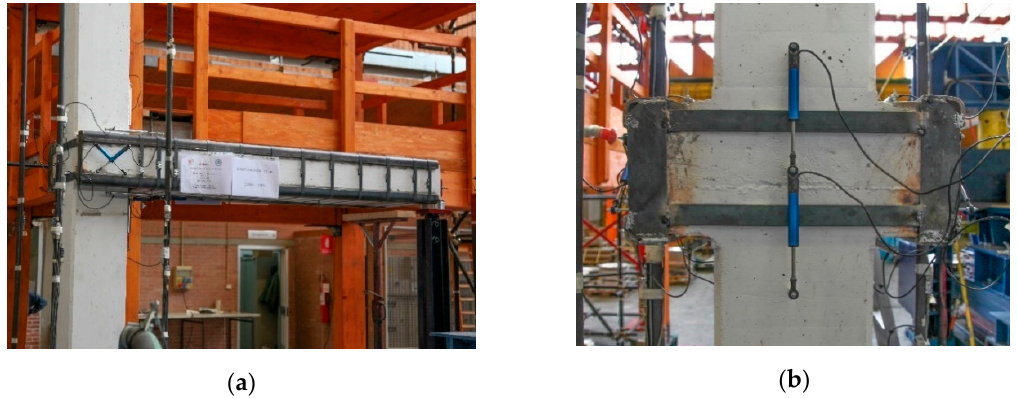
Figure 5. TS9 Specimen: ( a ) whole arrangement and ( b ) detail of the angles’ connection.